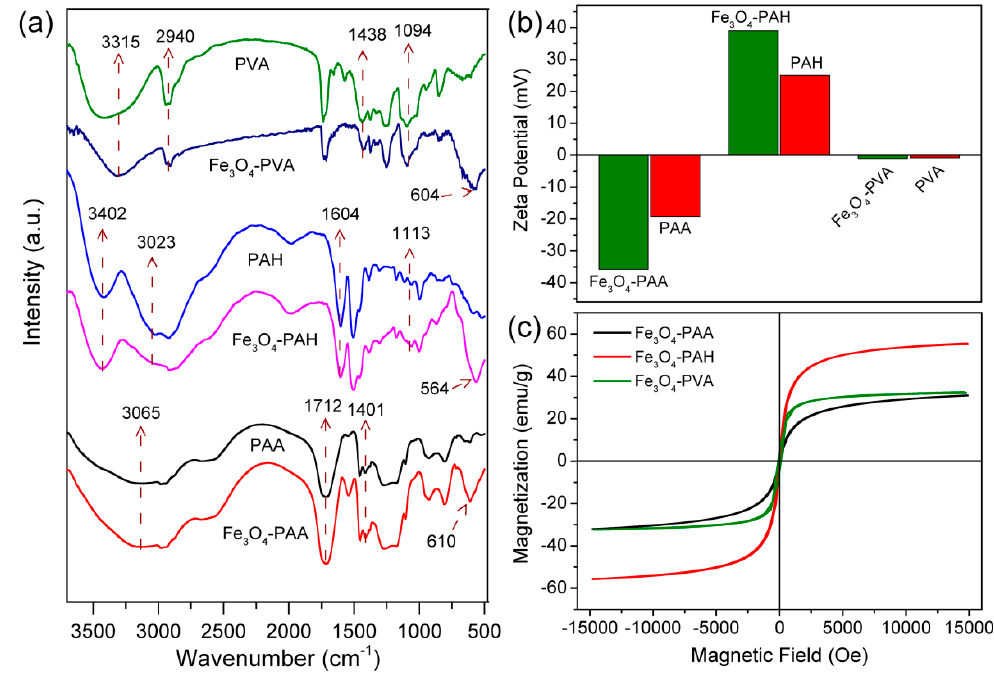
Figure 2. ( a ) FTIR spectroscopy and ( b ) Zeta potential of Fe 3 O 4 -PAA, PAA, Fe 3 O 4 -PAH, PAH, Fe 3 O 4 -PVA and PVA. ( c ) Field-dependent magnetization curves for Fe 3 O 4 -PAA, Fe 3 O 4 -PAH, and Fe 3 O 4 -PVA nanoparticles at 298 K.